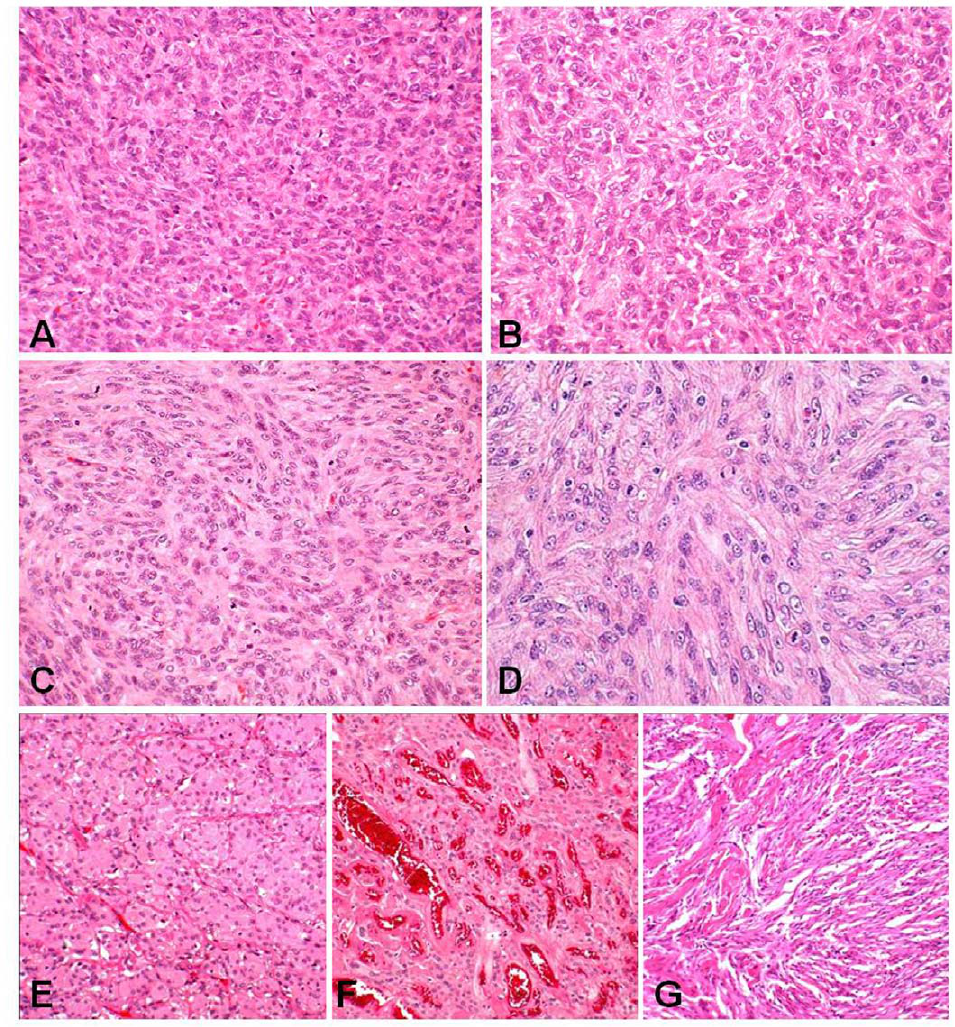
Figure 1. Histopathology of hemangiopericytoma, solitary fibrous tumor and meningiomas (H&E). Representative cases of selected hemangiopericytoma (A), solitary fibrous tumor (B), and, atypical (C), anaplastic (D), meningothelial (E), angiomatous (F), and fibrous (G) meningioma. Solitary fibrous tumors (A) and hemangiopericytomas (B) are occasionally difficult to distinguish from high-grade meningiomas (C, D).